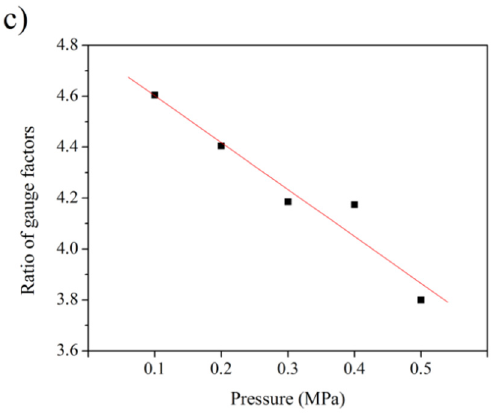
Figure 12. Comparison of the gauge factors between the graphene adsorbed with hydroxyl and clean graphene: ( a ) gauge factors; ( b ) ratio of gauge factors from ( a ); ( c ) ratio of gauge factors from Figure 5b.